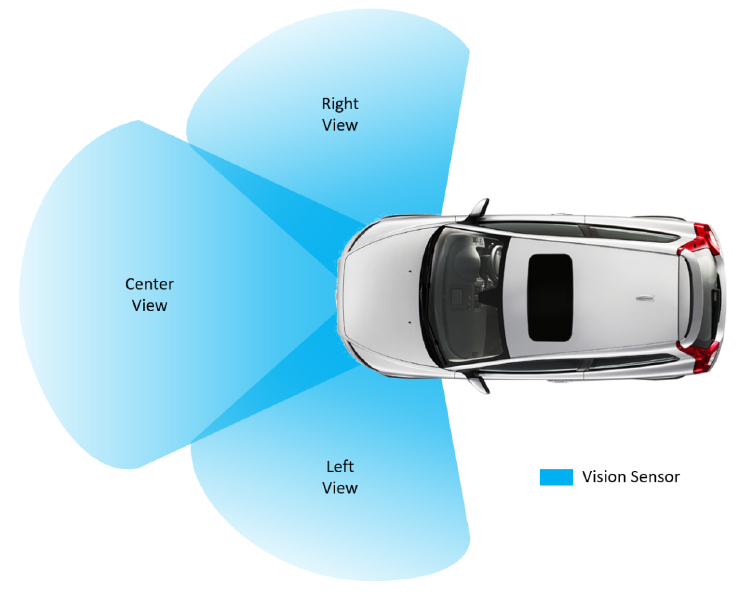
Figure 3. Vision sensor coverage of